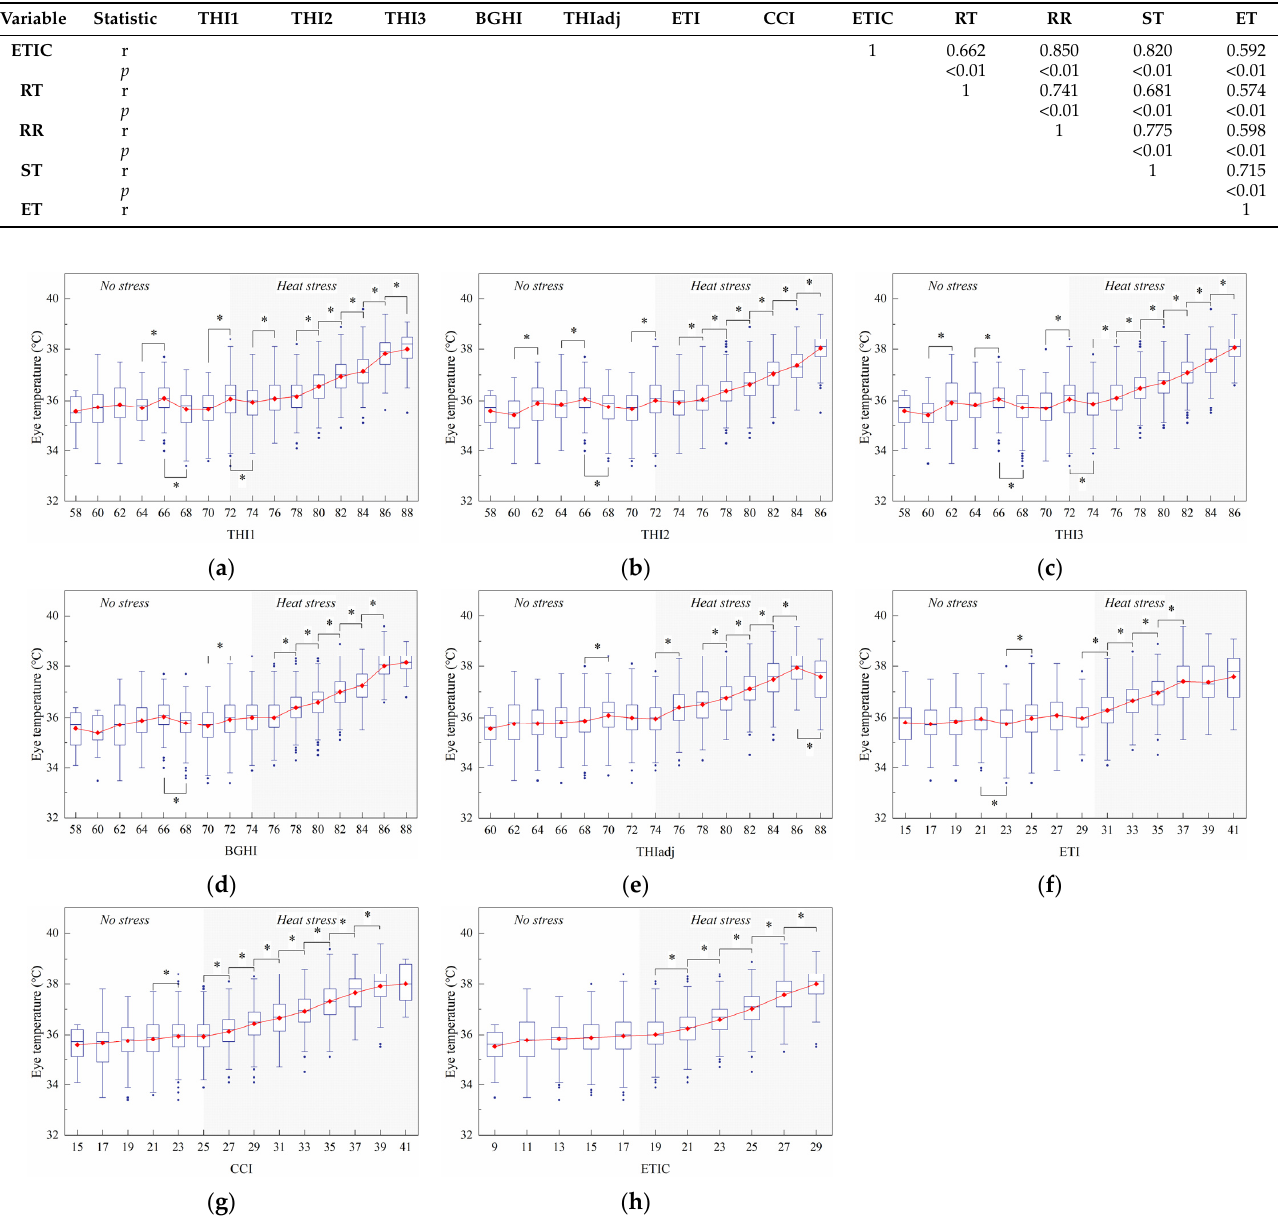
Figure 9. Effect of the thermal index values on eye temperature. The interquartile range (IQR) is shown by a blue box, the median as a blue horizontal line, the mean as a red square, and the whiskers extend to 1.5 IQR. Outliers are indicated by blue dots. An asterisk indicates a significant ( p < 0.05) change in the variable. The thermal indices are the temperature– humidity index (THI1 ( a ), THI2 ( b ), THI3 ( c )), black globe humidity index (BGHI ( d )), adjusted THI (THIadj ( e )), equivalent temperature index (ETI ( f )), comprehensive climate index (CCI ( g )), and equivalent temperature index for dairy cattle (ETIC ( h